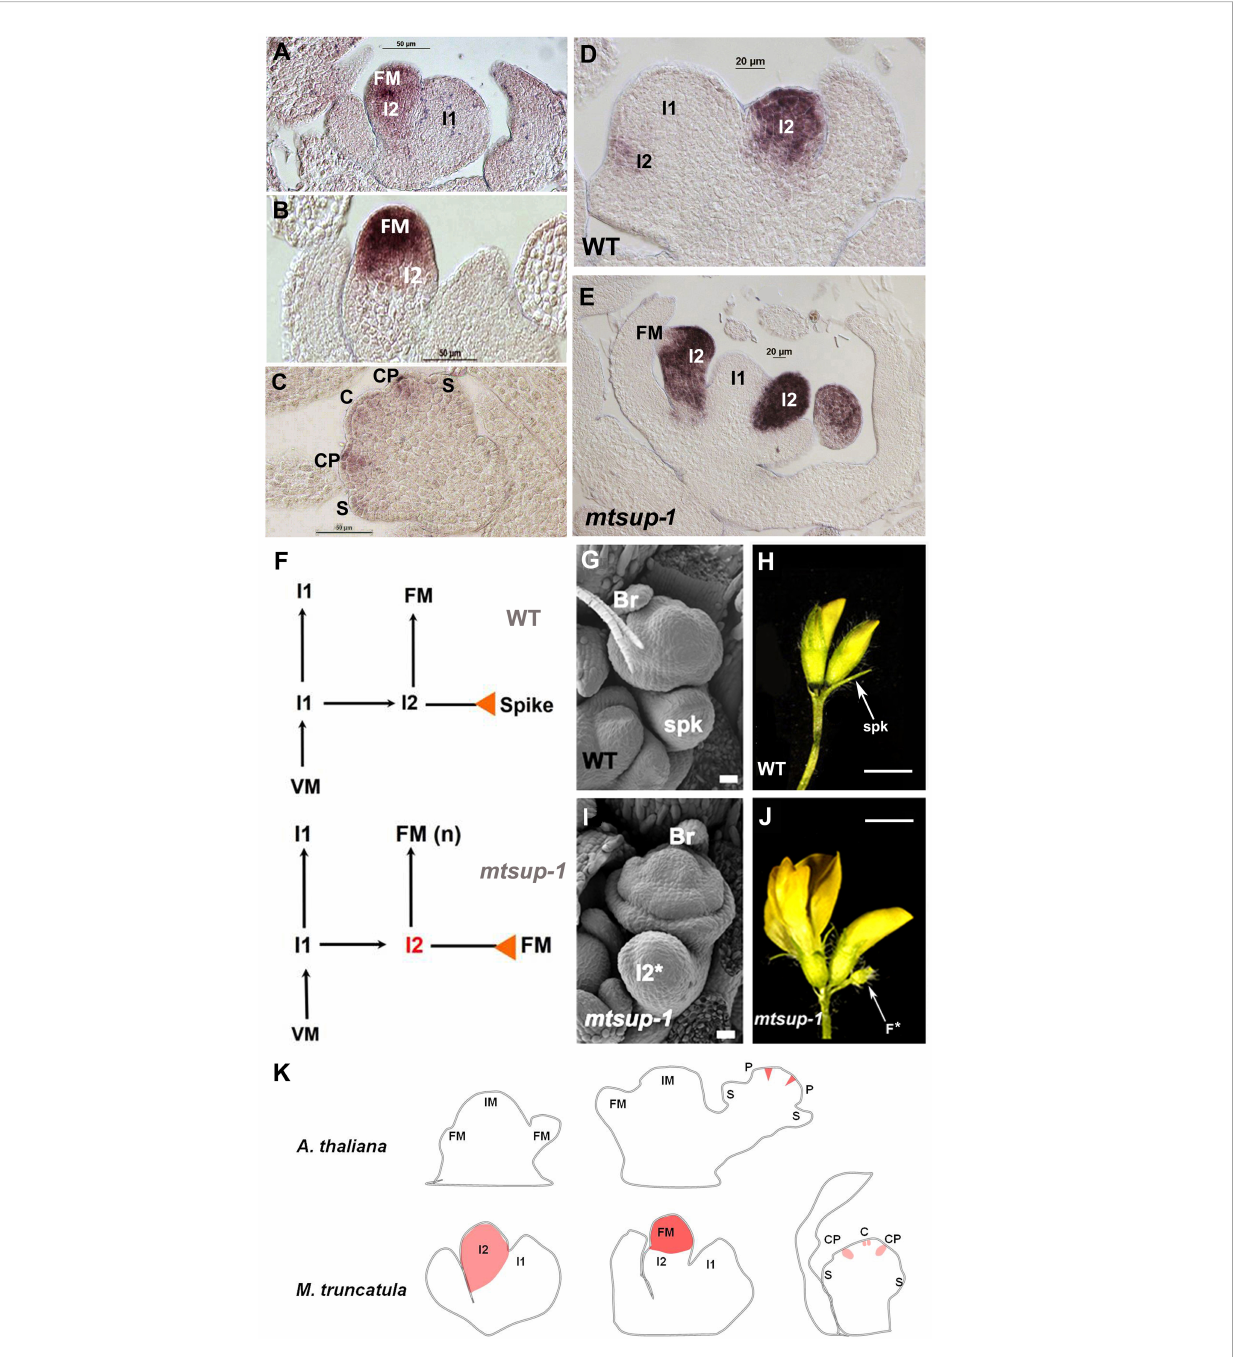
FIGURE 2 MtSUP controls compound in fl orescence development in M. truncatula . (A) MtSUP transcript is fi rstly detected in the I2. (B) Later on MtSUP activity is detected in the FM. (C) During early fl oral development MtSUP expression is detected in the common primordia (CP). (D) MtFULc expression in the wild type (WT) fl ower. (E) MtFULc expression in the mtsup-1 mutant. MtFULc transcript occupies a wider area in MtSUP mutants compared to the WT. (F) Schematic representation of the compound in fl orescence development in Medicago with the formation of an I2 and the terminal spike in the WT and a new FM instead the spike in the mtsup-1 mutant. (G) SEM image of a WT fl oral primordium with its respective bract and spike. (H) The WT of M. truncatula R108 produces one or two fl owers per in fl orescence and terminates in a spike. (I) In mtsup-1 , the I2* (future spike) acquires fl oral identity. (J) In the mtsup-1 mutant the residual cells of the I2 terminate as a new fl ower (F*) instead a spike. (K) Comparative schematic representation of SUP and MtSUP expression patterns during in fl orescence and fl ower development in Arabidopsis and Medicago. SUP and MtSUP are orthologs that have functionally diverged through changes in their gene transcription patterns. IM, in fl orescence meristem; I1, primary in fl orescence meristem; I2, secondary in fl orescence meristem; FM, fl oral meristem; CP, common primordium; S, sepal primordium; P, petal primordium; C, carpel primordium; Br, bract; Spk, spike; F*, new fl ower. Scale bars, 20 m m in (G, I) , and 2 mm in (H, J) Adapted from Rodas et al.